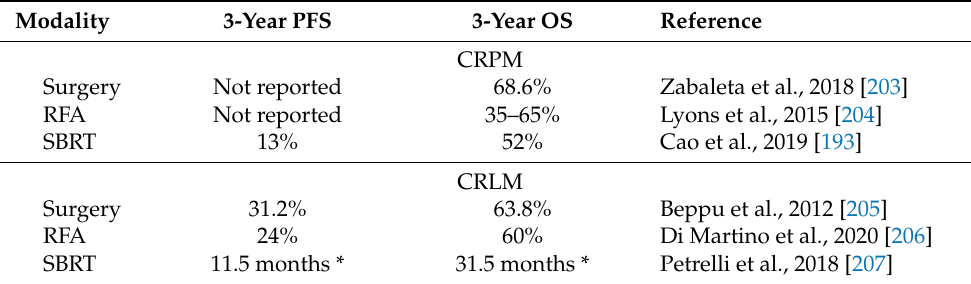
Table 1. Summary of meta-analyses investigating 3-year PFS and OS after surgical resection or local ablation of CRLM and